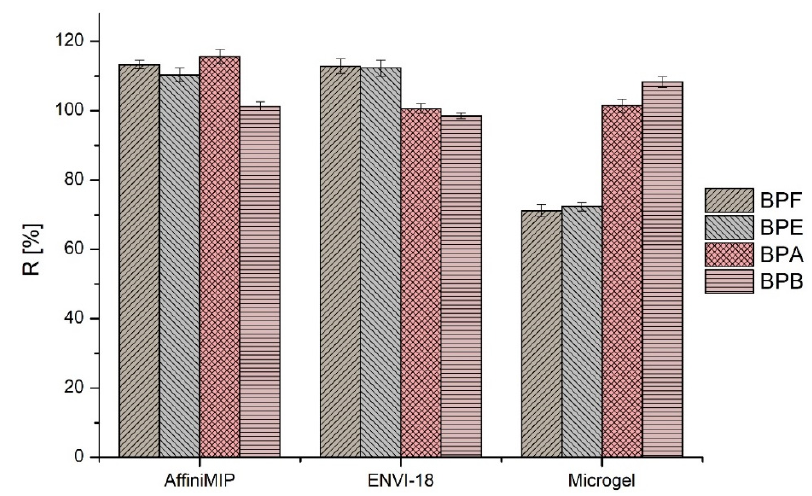
Figure 5. Comparison of our microgel performance with commercial SPE cartridges. Results ob- for fruits in syrup spiked with 50 µ g · L − 1 mixture of four bisphenols. Data are means with RSD ( n = 3). tained for fruits in syrup spiked with 50 µg·L − 1 mixture of four bisphenols. Data are means with RSD ( n = 3).